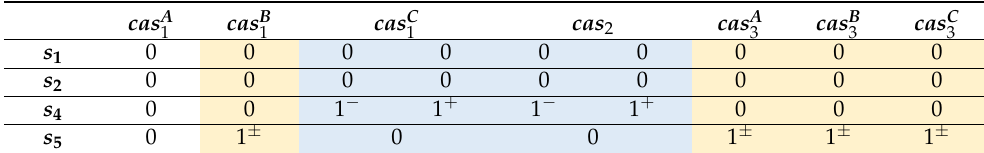
Table 7. Matrix of sensitivity of residues to factors related to the implementation of individual